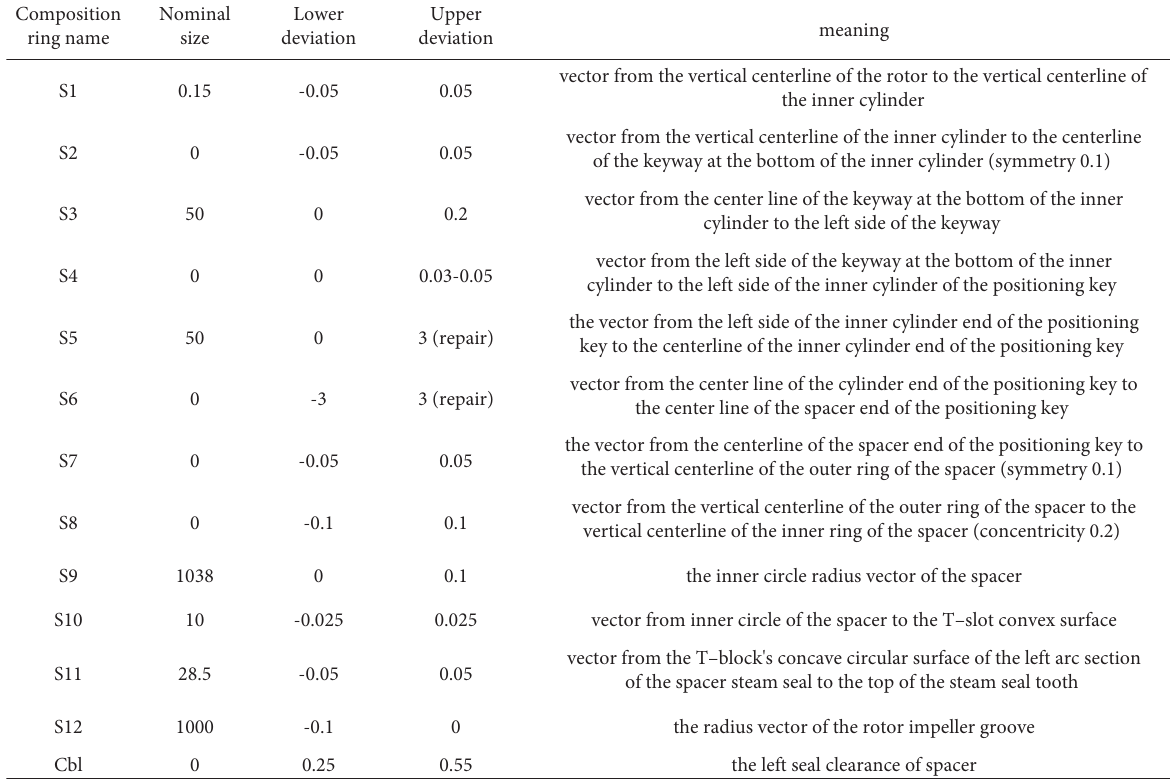
Figure 5: The meaning of the component rings and closed ring in the dimension chain of Figure